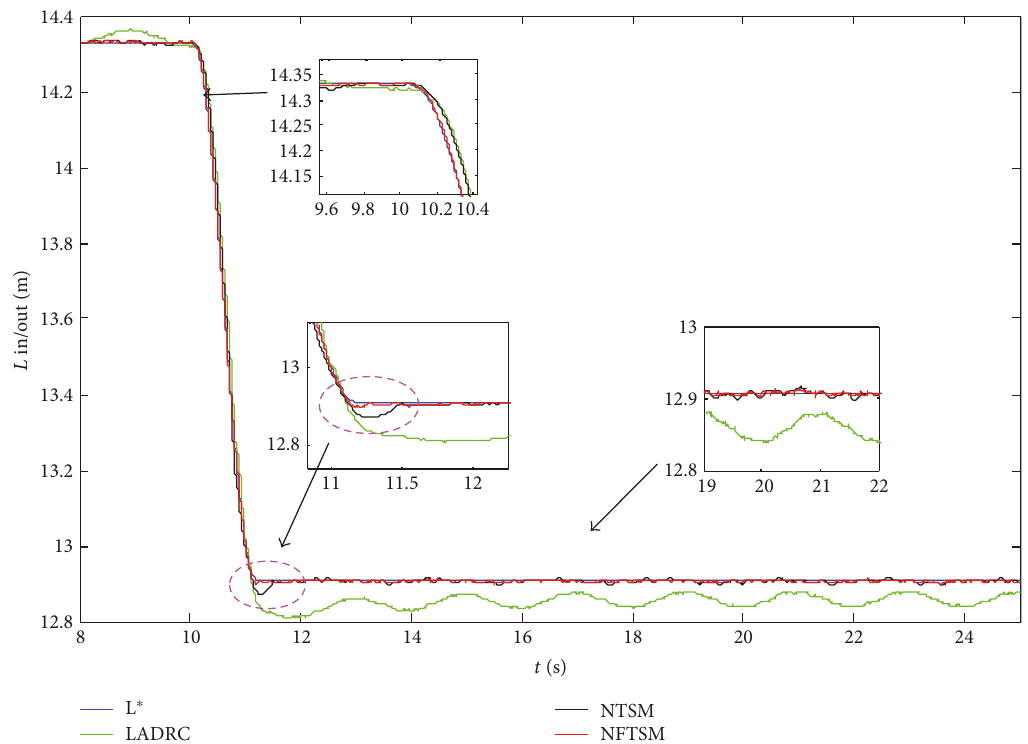
Figure 16: The hose length reeling in/out results by di ff erent